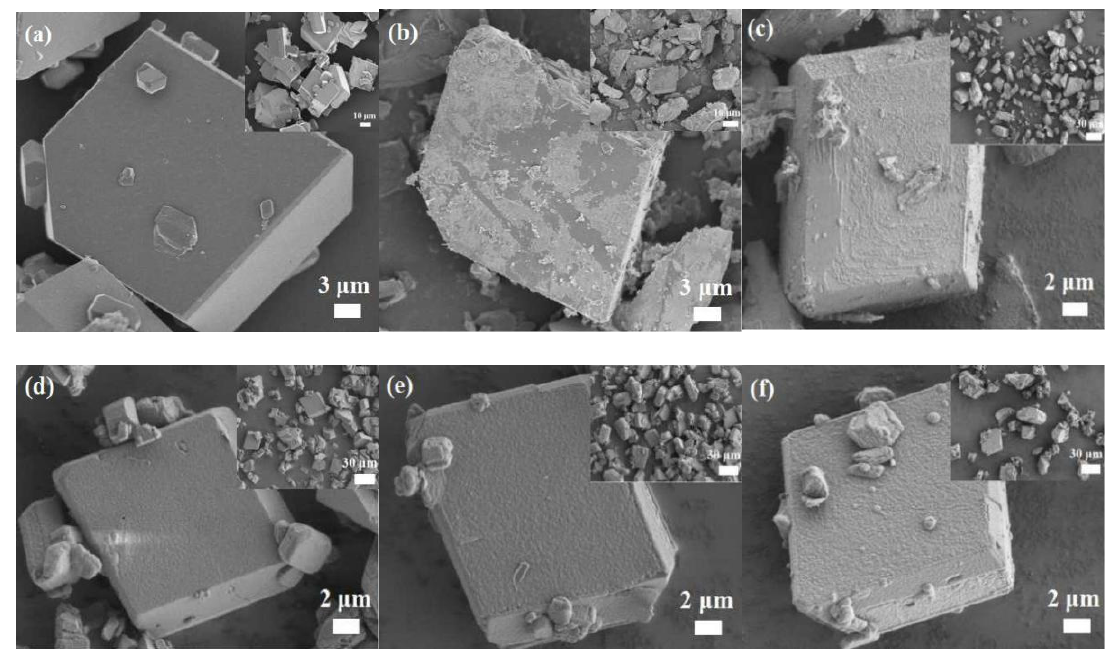
Figure 2. SEM images of ( a ) neat CL-20/HMX cocrystal and ( b ) CH@MF − 1 (0.5%); ( c ) CH@MF − 2 (1.0%); ( d ) CH@MF − 3 (1.6%); ( e ) CH@MF − 4 (2.8%); ( f ) CH@MF − 5 (3.5%). Corresponding images with low magnification are inserted.